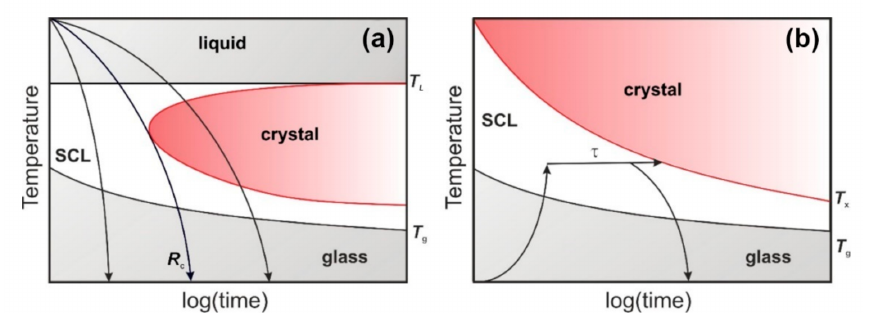
Figure 1. ( a ) Schematic continuous cooling transformation (CCT) diagram for a glass-forming system showing the critical cooling rate, R c , for glass formation; ( b ) schematic continuous heating transformation (CHT) diagram for conventional heating rates showing the principles of consolidation of amorphous powders. T L = liquidus temperature; SCL = supercooled liquid; τ = incubation